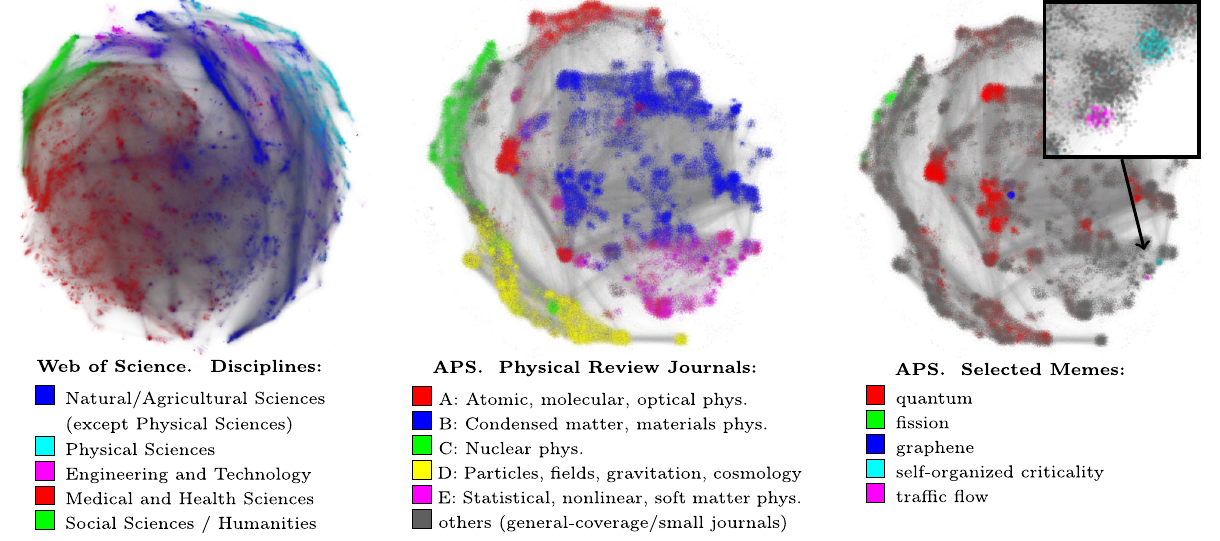
FIG. 1. Citation networks of the Web of Science and the American Physical Society (APS) data sets reveal community structures that nicely align with scientific disciplines, journals covering particular subfields, and occurrences of memes. The generation of the visualizations is based on Gephi [31] and the OpenOrd plug-in [30], which implements a force-directed layout algorithm that is able to handle very large